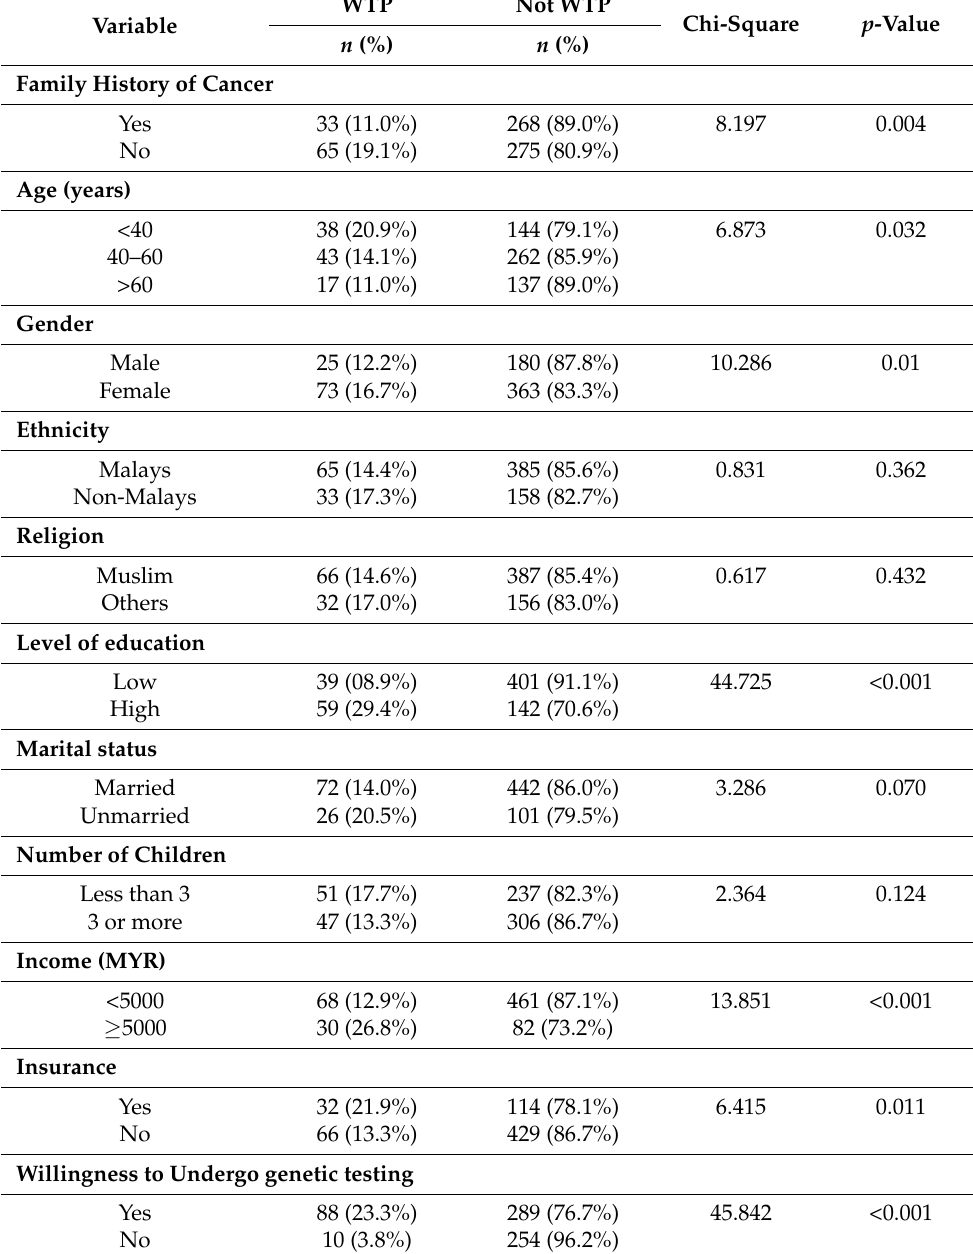
Table 2. Factors associated with WTP for cancer genetic testing in general ( n = 641). Pearson’s chi-squared test was performed, level of significance set at p <